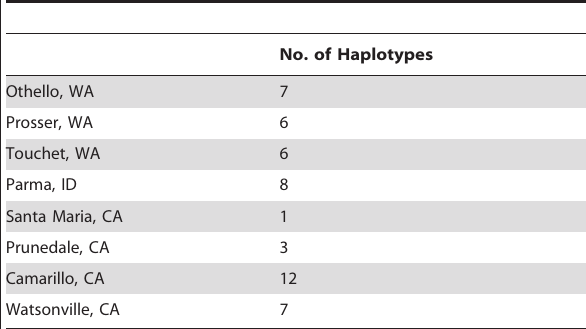
Table 3. The total number of haplotypes found at each collection site.